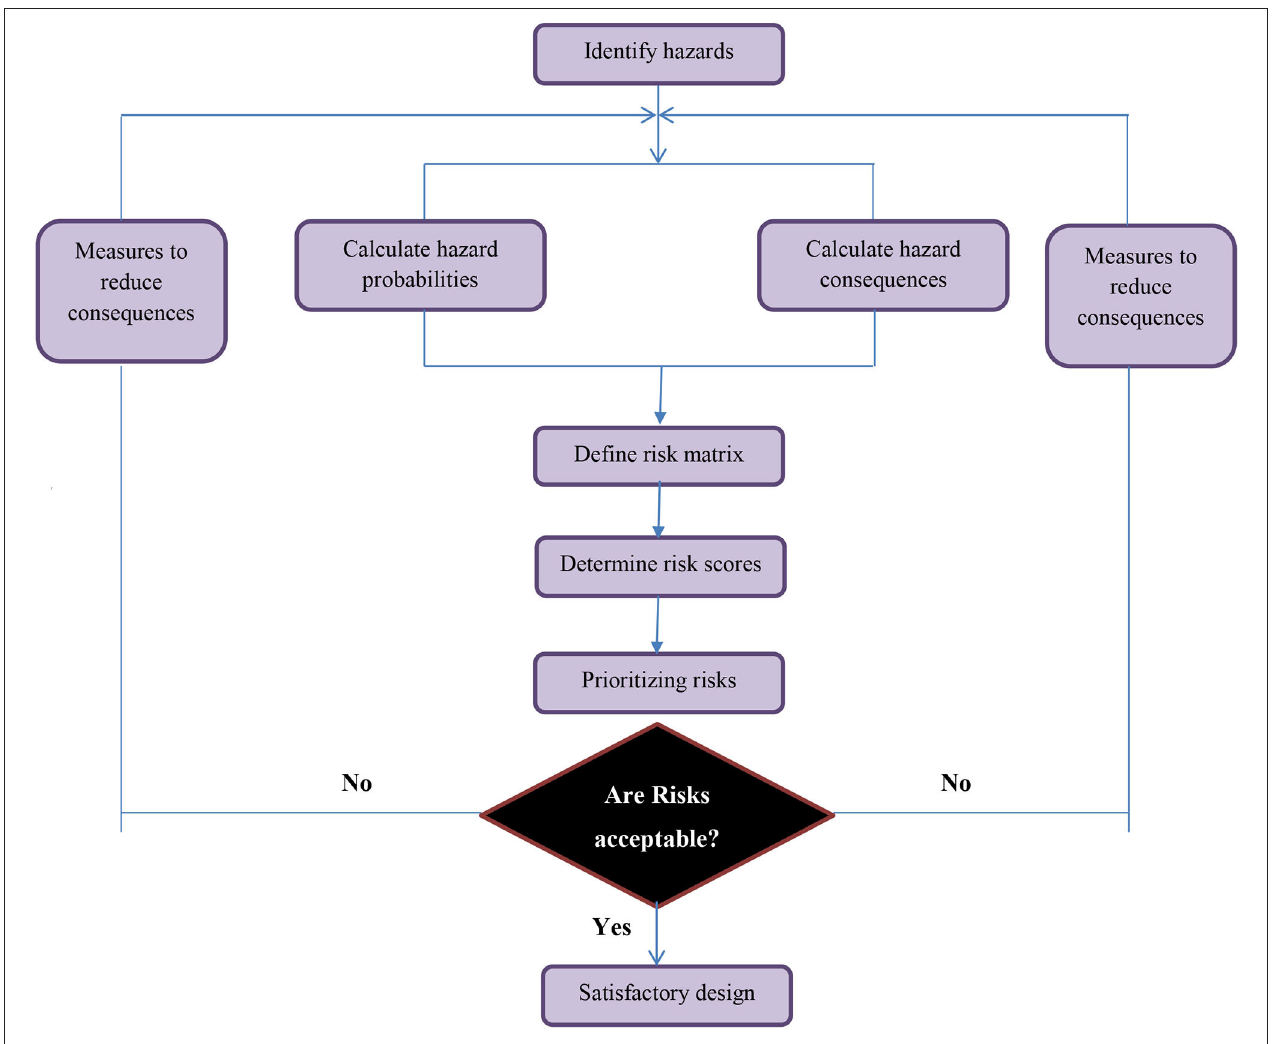
FIGURE 1 | Flowchart of the suggested methodology for risk